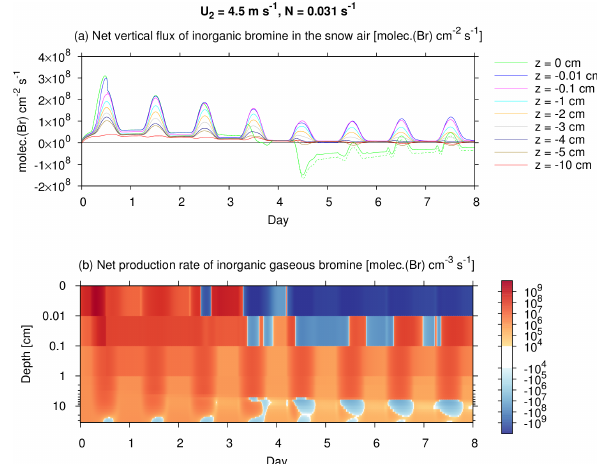
Fig. 8. Budget analyses of inorganic gaseous bromine in the snow- pack as simulated in the model run with U 2 = 4.5ms − 1 and N = 0 . 031s − 1 : (a) vertical fluxes at selected depth levels (solid lines) and the sum of the vertical fluxes of inorganic gaseous bromine and aerosol bromide at the top of the snowpack (green dotted line), and (b) net production (mostly via condensed-phase chemistry on the snow grain surface and subsequent release of products to the inter- stitial